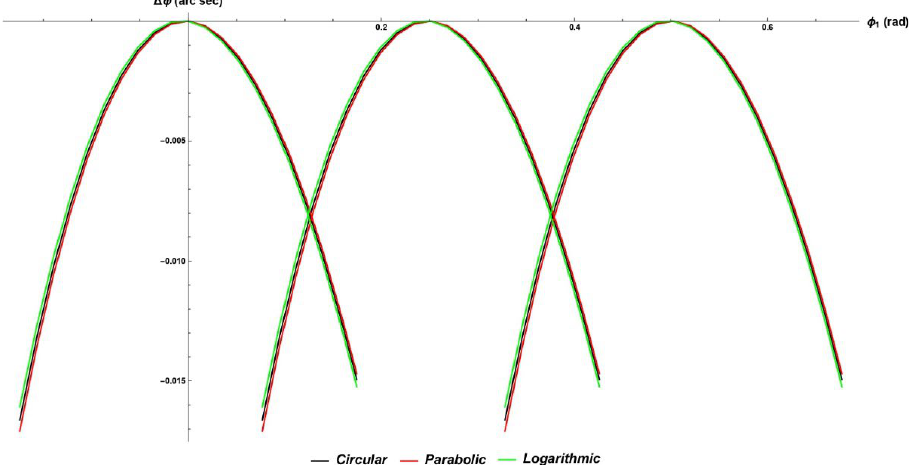
Figure 9. TE of crowned spur gear pair for the circular ( blue ), parabolic ( red ), and logarithmic ( green ) crowning function for a 0.4° (7.0 mrad) angular in-plane misalignment error. Further, Figure 10 displays the comparison of the contact paths of all three modifica- tions, which shows that for every type of modification, the point of contact is close to the center of the tooth surface. However, upon more precise examination, the contact path for a logarithmic function is located closer to the center of the tooth surfaces compared to others. For instance, along the tooth width, contact at the pitch point produced by the logarithmic function is closer to the center than the parabola by about 0.027 mm and to the circular function by approximately 0.015 mm. Simulations for other misalignment an- gles also show that different modifications almost equally affect the path of contact on the tooth surface, demonstrating similar results to each other but with marginally lower ∆𝜑𝜑 for the logarithmic function. Figure 10. Path of contact of longitude circular, parabolic, and logarithmic crowned spur gear with 0.4° (7.0 mrad) of in-plan angular misalignment. The dashed line is the center of the tooth surface along gear width. 6.3. Simulation of Spur Gears Meshing with Out-of-Plane Misalignment The misalignment angle and plane in the case of out-of-plane misalignment are shown in Figure 4b. Table 3 shows the values of the maximum amplitude of TE functions ( ∆𝜑𝜑 𝑚𝑚𝑎𝑎𝑥𝑥 ) and the modification parameters of the three crown types at an angular pitch